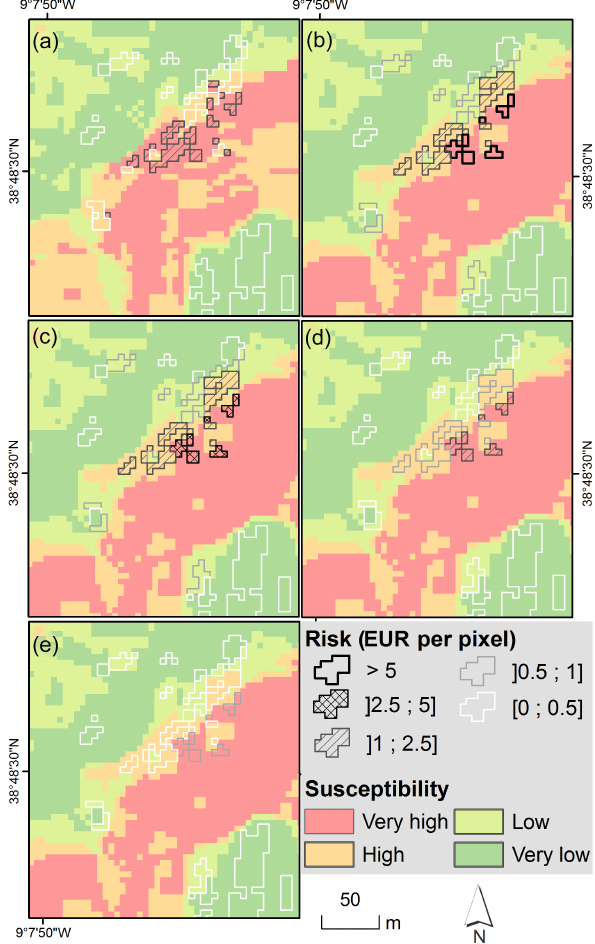
Figure 13. Detail of annual risk for buildings of the Loures mu- nicipality located on a landslide body, for a slip surface depth of (a) 1m, (b) 3m, (c) 5m, (d) 10m, and (e) 20m. Pixel size: 5m. For location, see Fig.